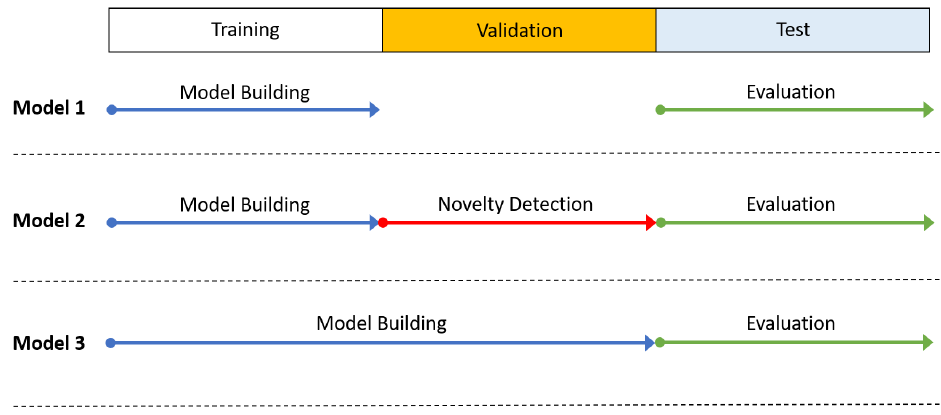
Figure 3. Implementation of the 3 models based on training and validation